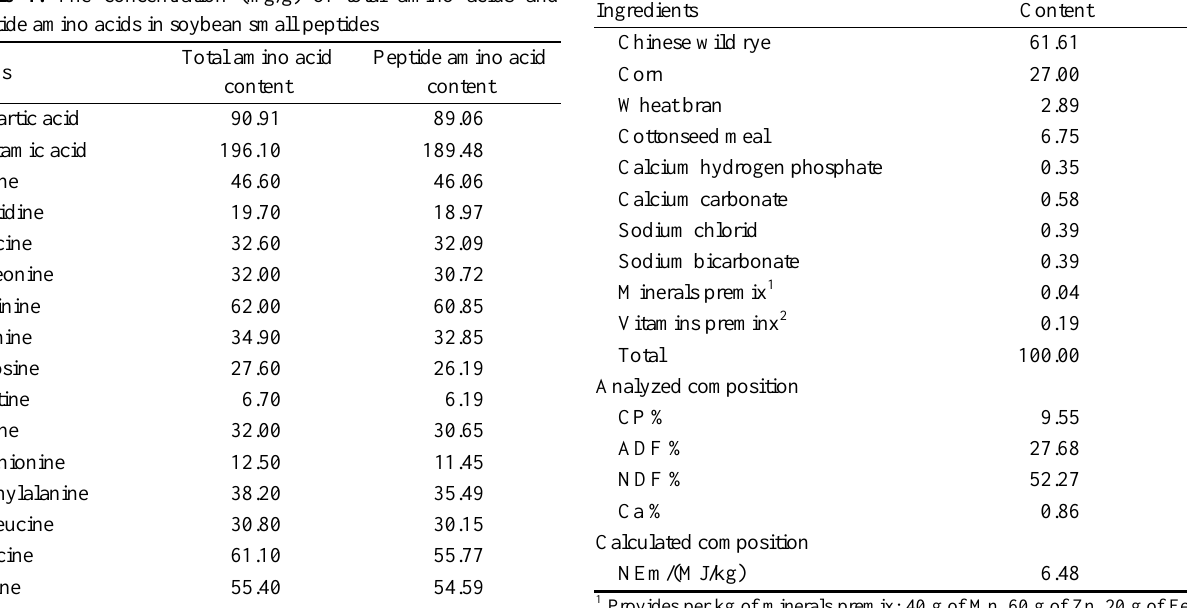
Table 1. The basal diet (Table 2) was a total mixed ration (TMR) formulated to meet the nutrient requirements of cattle (Feeding Standard of Cattle of the People’s Republic of China, NY/T815- 2004). The TMR was offered in equal amount twice daily at 07:00 and 19:00 for 95% of the ad libitum intake and all cattle had free access to fresh water.